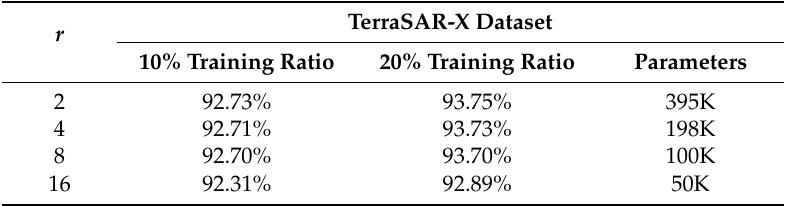
Table 2. Evaluation of the ratio of reduction.